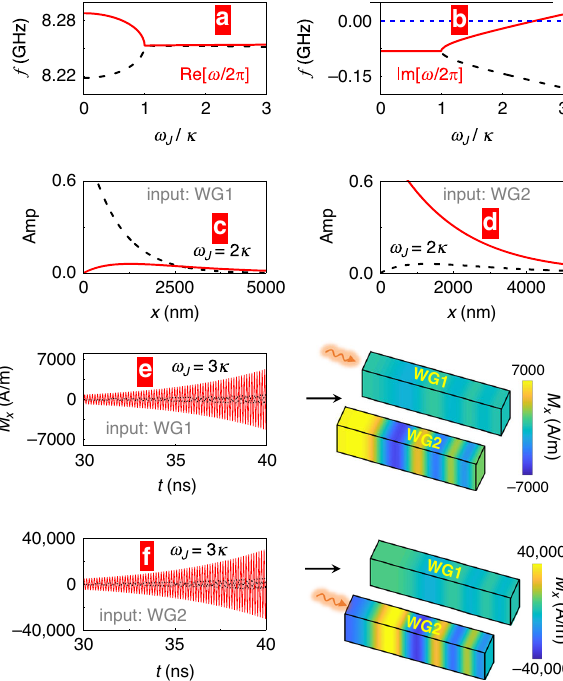
(cid:2) ( a ) and Im ½ χ (cid:2) ( b ) Fig. 3 Enhanced sensing. Magnetic susceptibility Im ½ χ 11 12 Fig. 4 Magnon ampli fi cation. a , b Real and imaginary parts of the (cid:2) and Im ½ χ (cid:2) are found at the as functions of f and ω J . Peaks in Im ½ χ 11 12 eigenmodes ω as varying the loss/gain balance by scanning ω J (meaning, exceptional point ω J = κ . c – f Exciting spin waves of frequency 20 GHz at the SOT strength). The wave vector is k x = 0.03 nm − 1 and the intrinsic x = 0 in WG1, spatial pro fi les of spin-wave amplitude for different ω J . Black coupling between WG1 and WG2 κ is lowered, as compared to Fig. 1 (by solid line and red dashed line represents the amplitudes in WG1 and WG2, choosing J RKKY = 9 × 10 − 7 J/m 2 ). c , d Spatial pro fi les of magnon wave respectively. Near ω J = κ , a slight variation in ω J causes marked changes in amplitudes (as normalized to their maxima) for ω J = 2 κ , and the spin-wave amplitudes ( e , f ), while the change is negligible near (Re ½ ω (cid:2) ¼ 2 π ´ 20 GHz). Black dashed line corresponds to WG1 and red ω = 0.7 κ ( c , d ). g , h At ω = κ , increasing the external magnetic fi eld J J solid line to WG2. e , f Time dependence (at the location x = 2000 nm) and ( H 0 = 2 × 10 5 A/m) in WG1 by 100 A/m, the time dependence of M x (g) the spatial pro fi les (at t = 40 ns) of the x component of the magnetization and M y (h) at x = 2000 nm in WG2. M ω = 3 κ . The color variation from blue to red corresponds to a M x for J change from the negative maximum to the positive